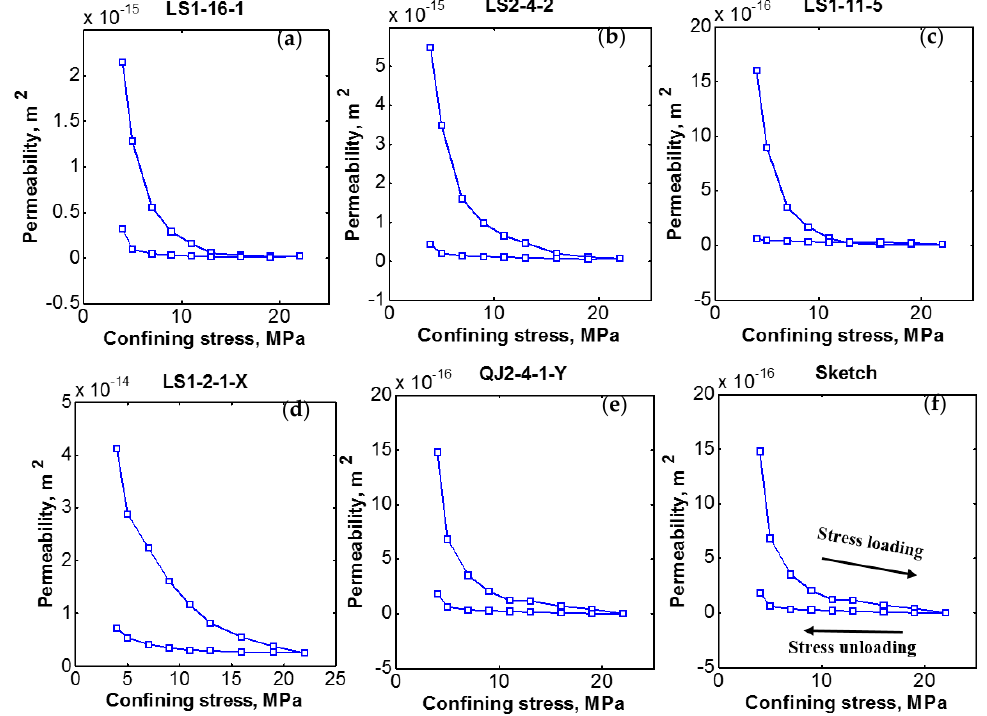
Figure 2. Lab measured correlations between permeability and confining stress. ( a ) LS1-16-1; ( b ) LS2-4-2; ( c ) LS1-11-5; ( d ) LS1-2-1-X; ( e ) QJ2-4-1-Y; ( f ) Sketch.